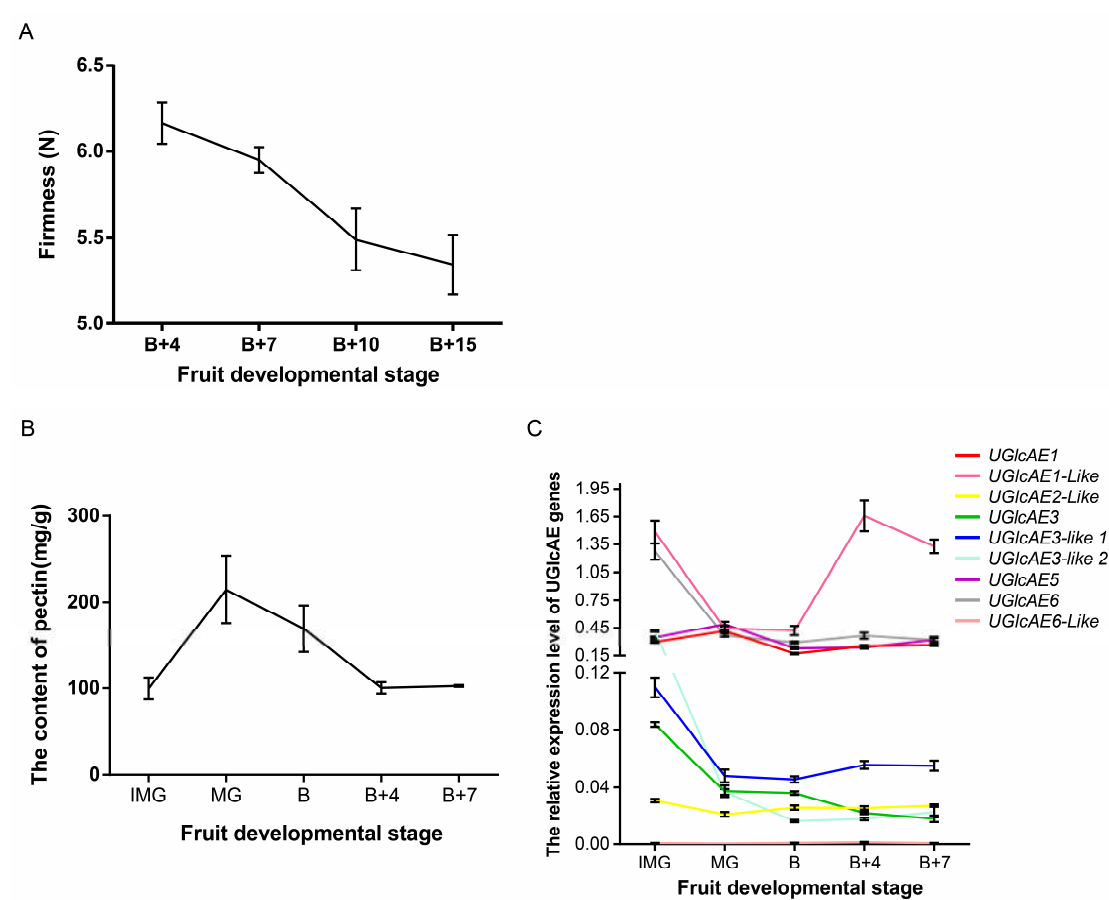
Figure 10. Firmness, pectin contents, and expression levels of UGlcAE family genes during the development of tomato fruit. ( A ) Firmness of tomato fruit in five different stages; ( B ) water-soluble pectin (WSP) contents of fruit in five development stages; and ( C ) Expression level of nine UGlcAE family genes in stages.